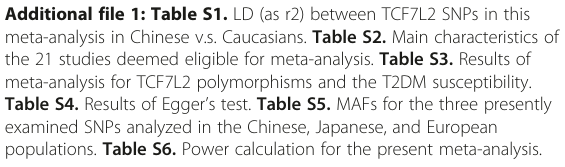
Table S4. Results of Egger ’ s test. Table S5. MAFs for the three presently examined SNPs analyzed in the Chinese, Japanese, and European populations. Table S6. Power calculation for the present